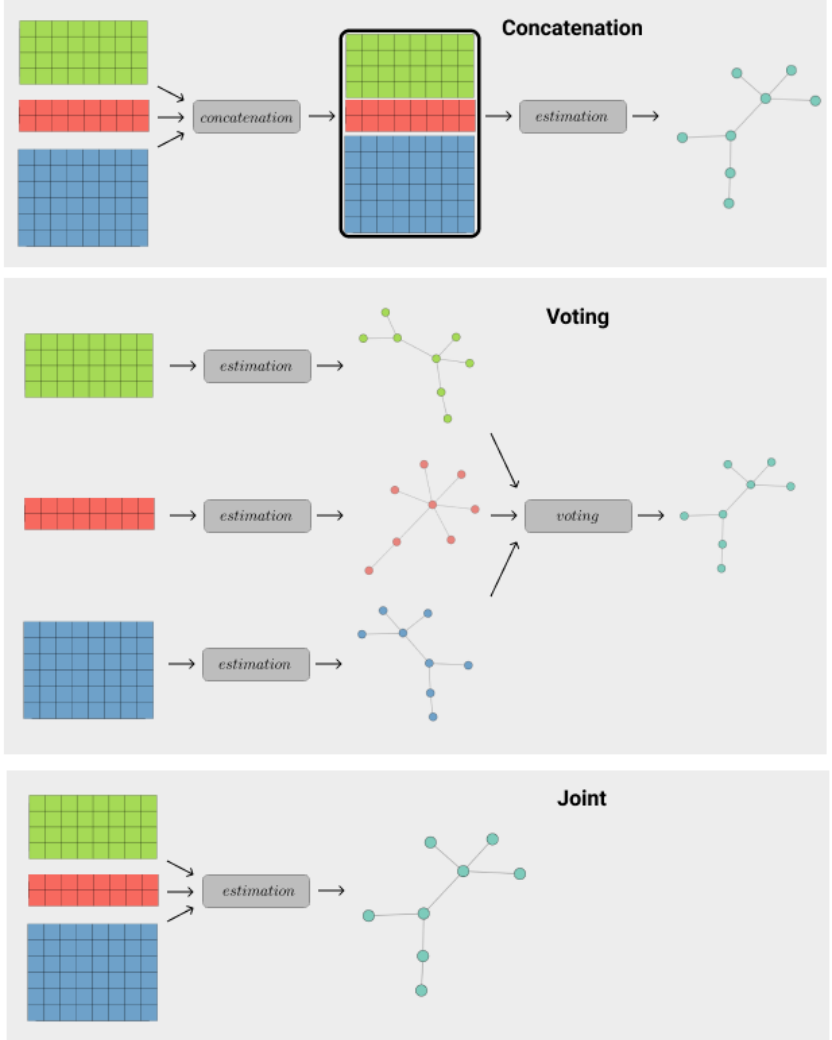
Figure 2. Different approaches that can be used for analyzing multiple datasets. Top panel: concate- nation. Middle panel: voting. Bottom panel: joint